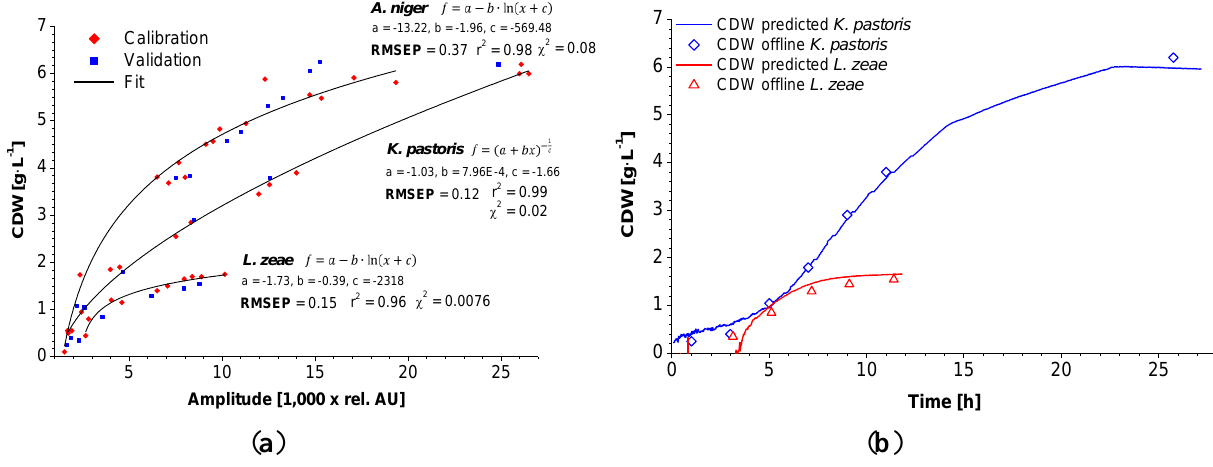
Figure 3. Exemplary dynamic calibration of the biomass sensor signal versus CDW for K. pastoris , A. niger and L. zeae ( a ). Red diamonds represent two experiments. Blue squares represent one validation experiment. Application of the calibration function on the biomass sensor signal of the validation growth curve along with the offline measured data ( b